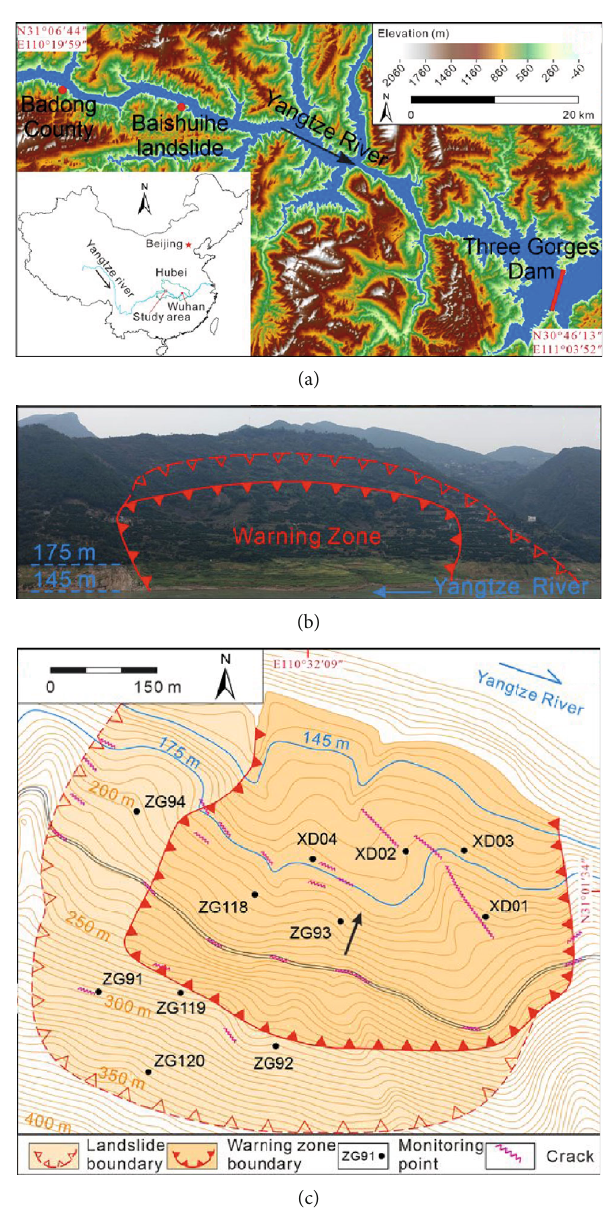
Figure 1: (a) Geographic location of the Baishuihe Landslide in the Three Gorges Reservoir area, China. (b) Overall view of the Baishuihe Landslide. (c) Topographic map of the Baishuihe